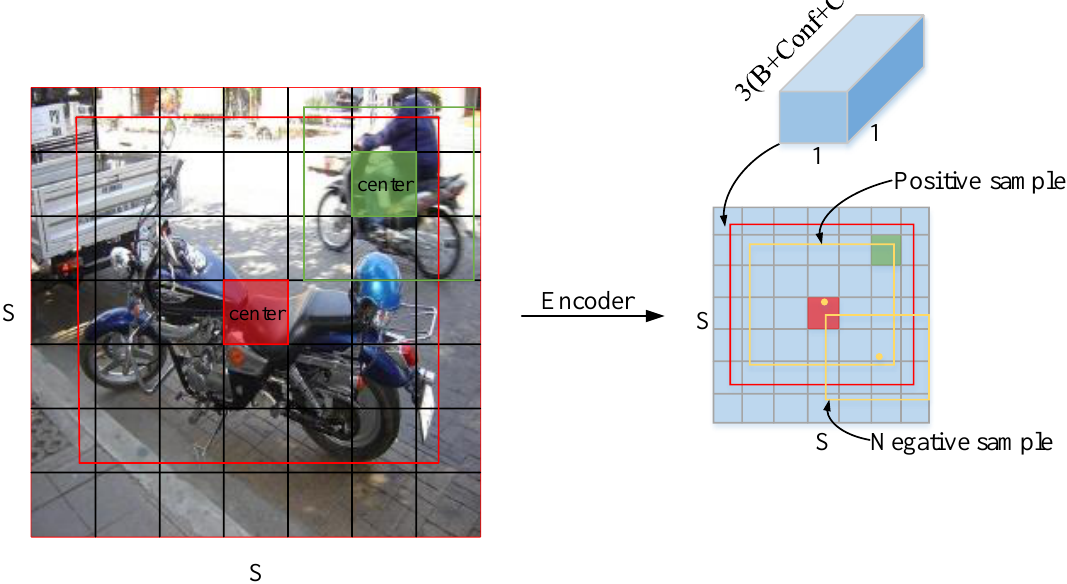
Figure 4. Mapping relationship between the image and feature. In the left image, the red and green boxes are ground-truth boxes. In the right feature, the red box is a ground-truth box, and the yellow box is an anchor. The center points of the anchor and ground-truth bounding boxes that fall on the same grid cell were designated as positive samples, and other anchors were designated negative samples. If the Intersection over Union (IOU) of the anchor and ground truth is greater than the threshold but the center points do not fall on the same grid cell, then the anchor it is regarded as a negative sample.